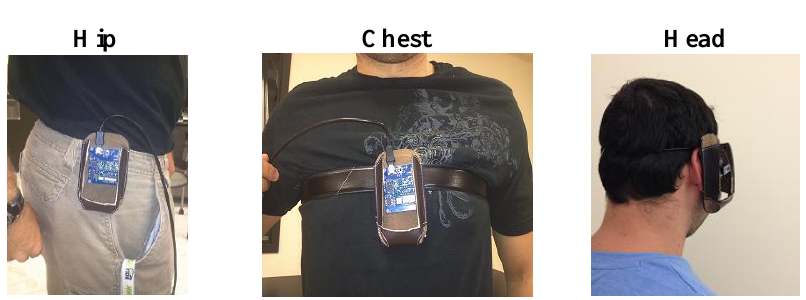
Figure 2. Sensor locations.